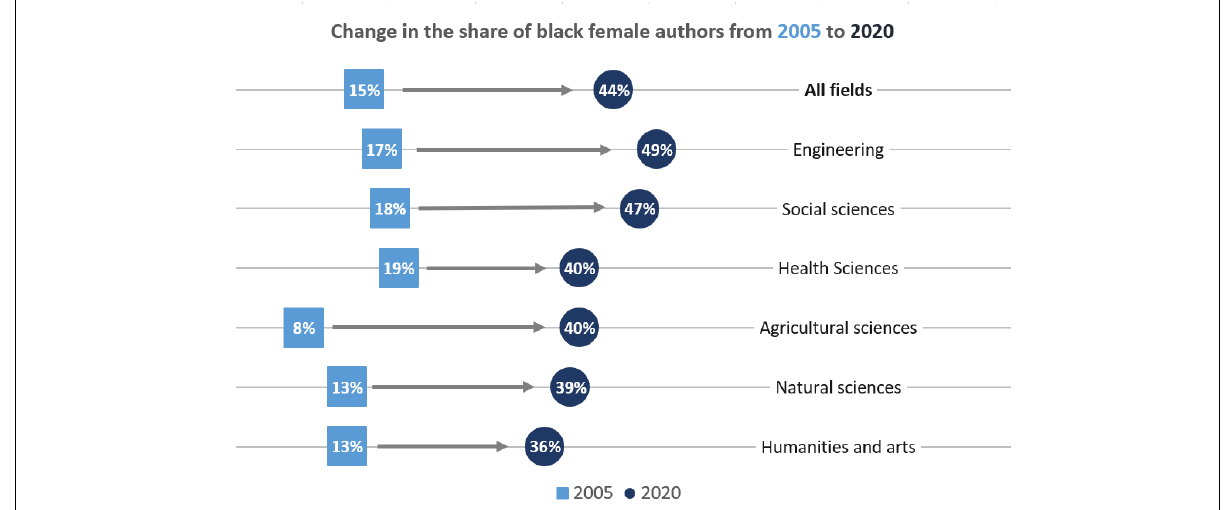
Figure 2: Change in the share of female South African authors by science domain between 2005 and